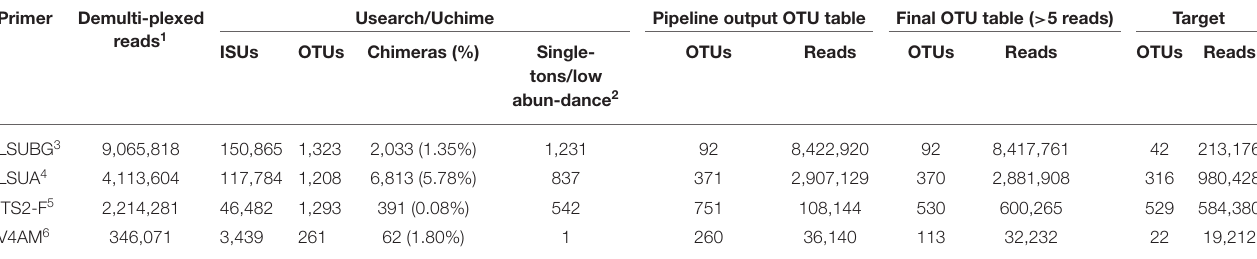
TABLE 2 | Summary of demultiplexed Individual Sequence Units (ISUs) and clustered Operational Taxonomic Units (OTUs) from each of the 4 fungal primer sets used in this study. Primer Demulti-plexed Usearch/Uchime Pipeline output OTU table Final OTU table ( > 5 reads) Target reads 1 ISUs OTUs Chimeras (%) Single- OTUs tons/low abun-dance 2